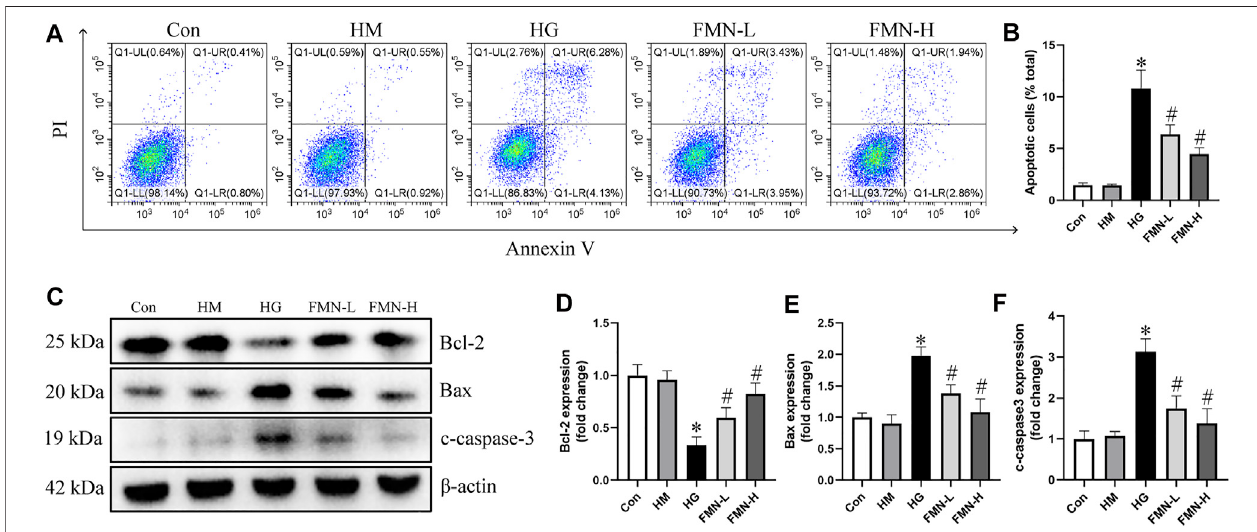
FIGURE 6 | FMN reduced the apoptosis of HK-2 cells under HG exposure. (A,B) Representative images of fl ow cytometry and quantitative analysis of apoptosis rate in HK-2 cells. n = 3 (C – F) Representative images of Bcl-2, Bax and c-caspase-3 protein expression and semiquantitative analyses in different groups. Results were expressed as mean ± SD. * p < 0.05 vs. control group. # p < 0.05 vs. HG